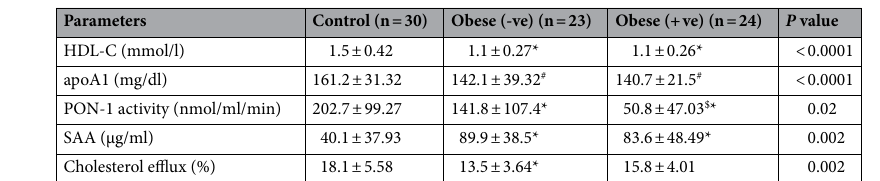
Table 3. HDL functionality in control and obese participants with and without small fibre neuropathy. Results reported as mean ± standard deviation. HDL-C, high density lipoprotein cholesterol; apoA1, apolipoprotein A1; PON-1, paraoxonase-1; SAA, serum amyloid A. *indicates P < 0.01 compared to control. # indicates P < 0.05 compared to controls. $ indicates P < 0.01 compared to obese without small fibre